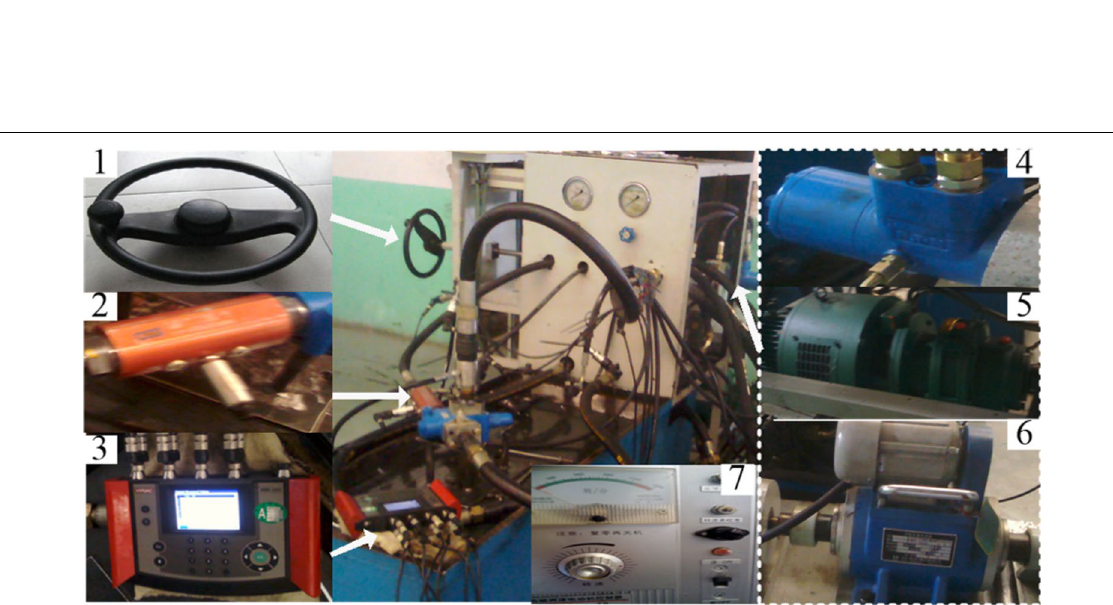
Figure 11 Photograph of the redirector experimental platform: (1) steering wheel, (2) pressure sensor, (3) data acquisition, (4) redirector, (5) pump, (6) electromotor, and (7)